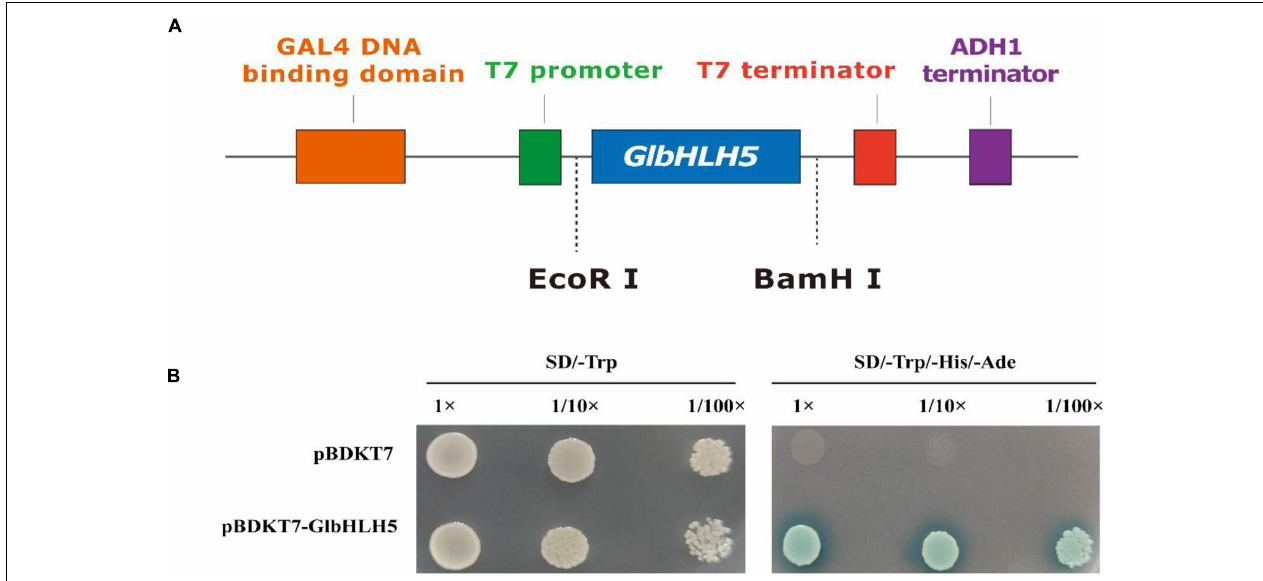
FIGURE 3 | Transcriptional activation analysis of GlbHLH5. (A) The construction of the vector pGBKT7- GlbHLH5 . (B) Transcription activation activity of GlbHLH5 . 3-AT was added at a final concentration of 0.5 mmol L − 1 .